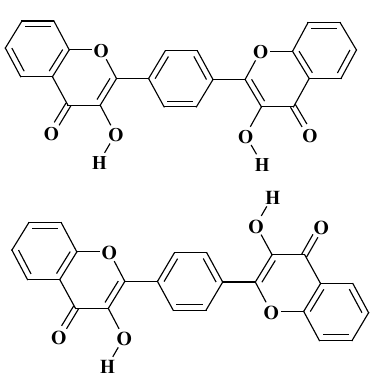
Figure 5. Syn - (top) and anti - (bottom) conformations of bis-flavonol